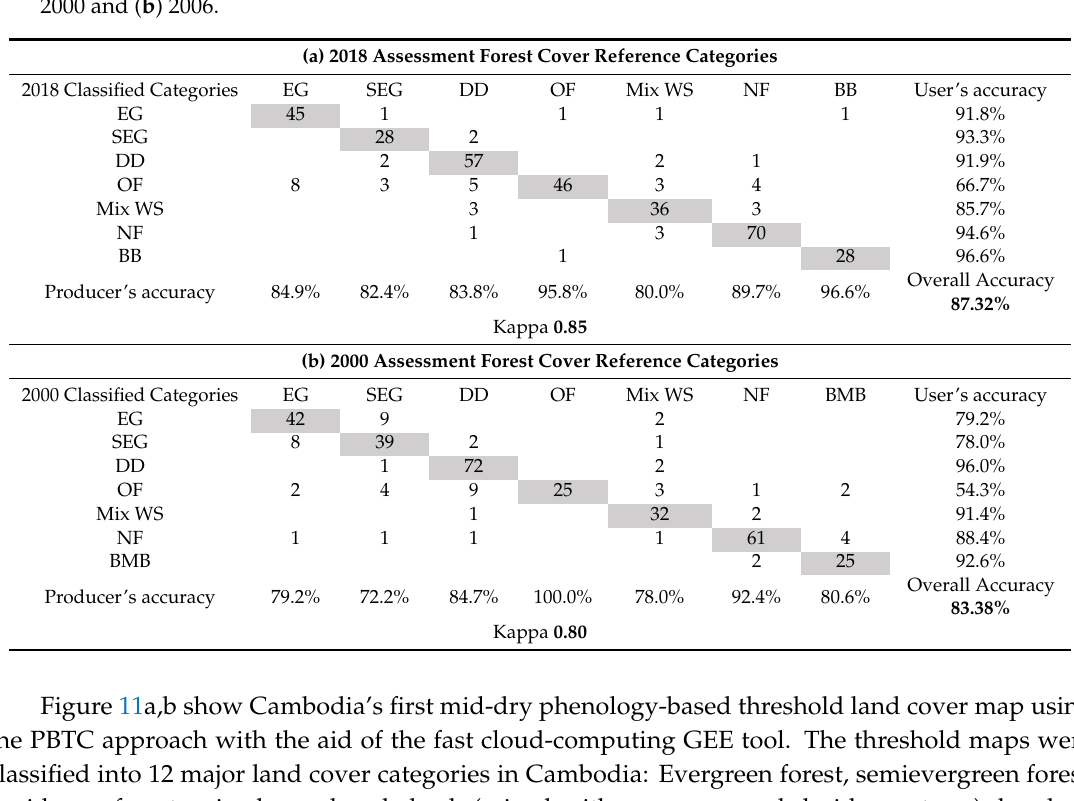
Table 4. Results of the accuracy assessment for the TM 2000 and OLI 2018 classified maps. The values of the 7 land cover categories were derived using the maps with the reference forest cover data in ( a ) 2000 and ( b ) 2006.